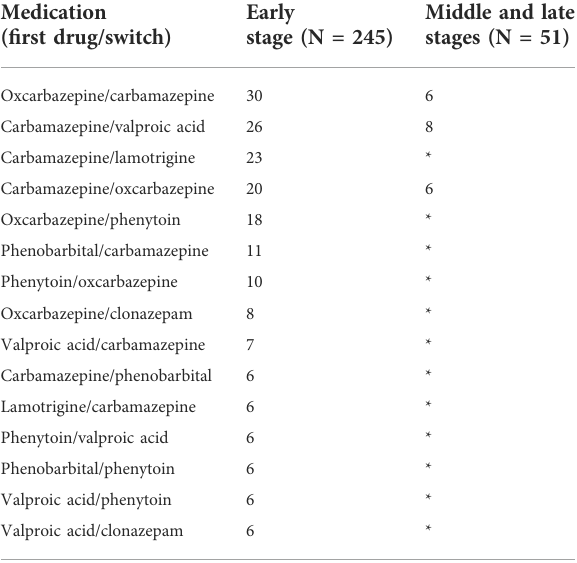
TABLE 3 Manual revision of switch medication events — phases: early, middle, and late.